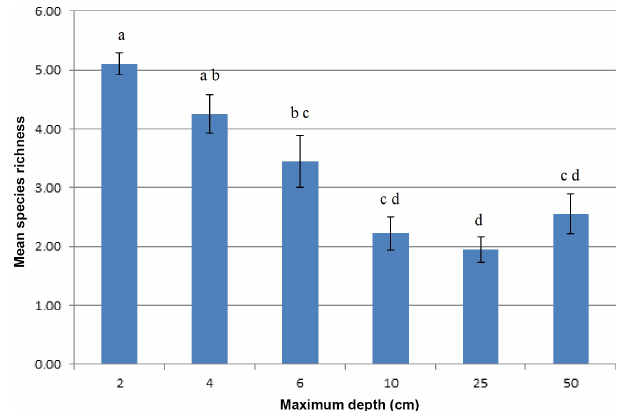
Figure 8. Mean number of cyanobacterial morphotypes with stan- dard errors in topsoil stockpiles. Different letters indicate significant differences between